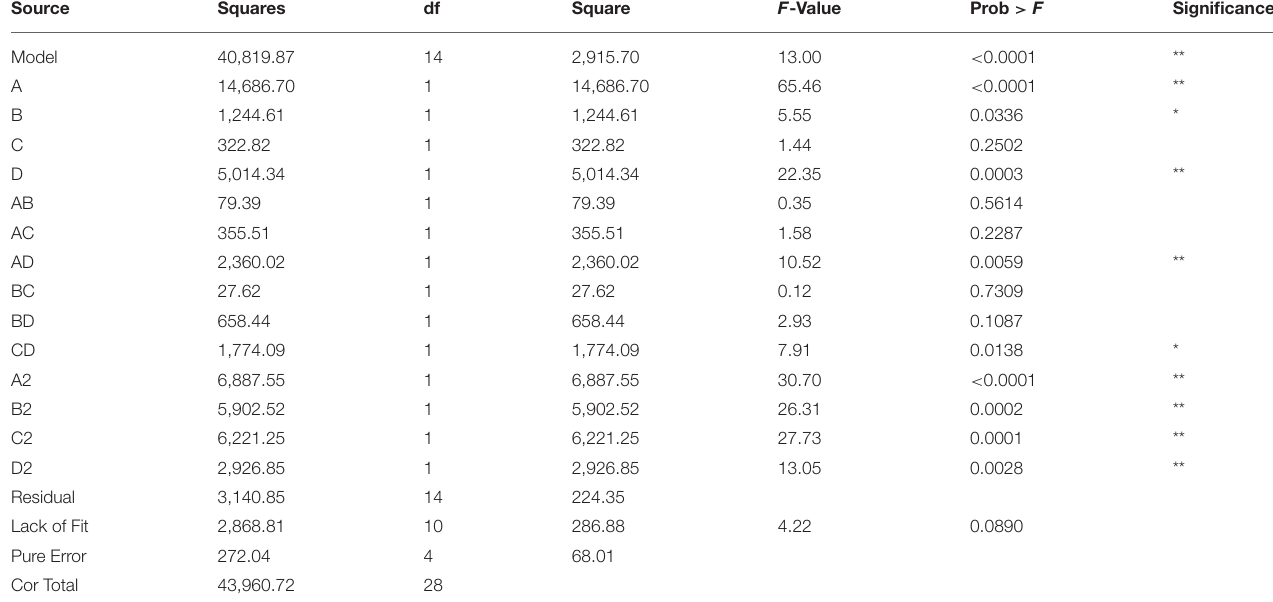
TABLE 2 | ANOVA in response surface regression model.